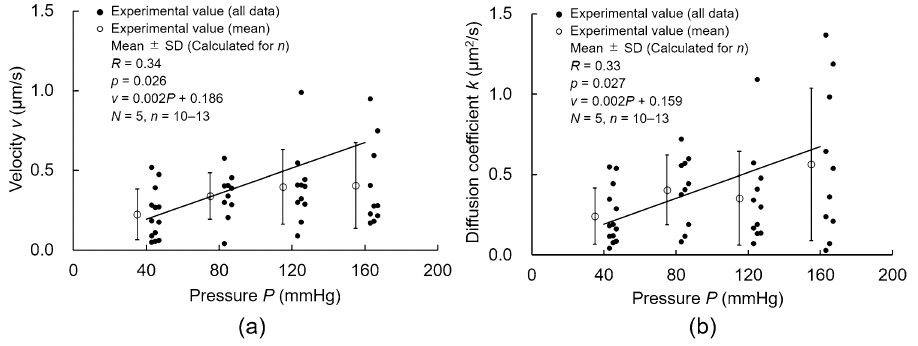
Figure 6. Correlations between intraluminal pressure P and both ( a ) interstitial flow velocity v and ( b ) diffusion coefficient k . N , number of mice; n , number of data ; R , correlation coefficient. The correlation coefficient R was tested using the Student’s t -test. The graph was created using the Microsoft Excel for Microsoft 365 MSO